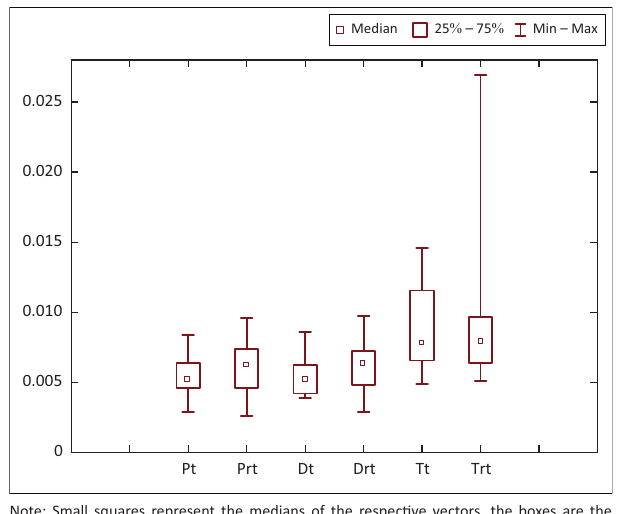
FIGURE 3: Stereo pairs of a colour space with 20 comets joining the Cambridge Colour Test - Trivector test and retest measurements. The origin represents 0 u ’ v ’ units (or a chromatic Trivector [ p d t ] ʹ of [0 0 0] ʹ ) and the axis lengths are 0.01 u ’ v ’ units.